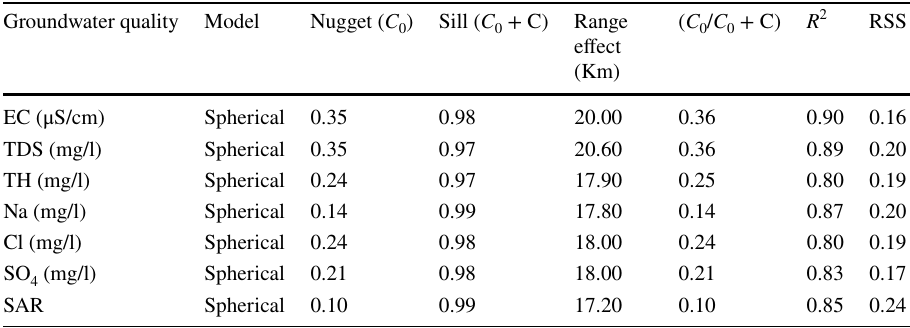
Table 2 Best-fitted variogram models of groundwater quality and their